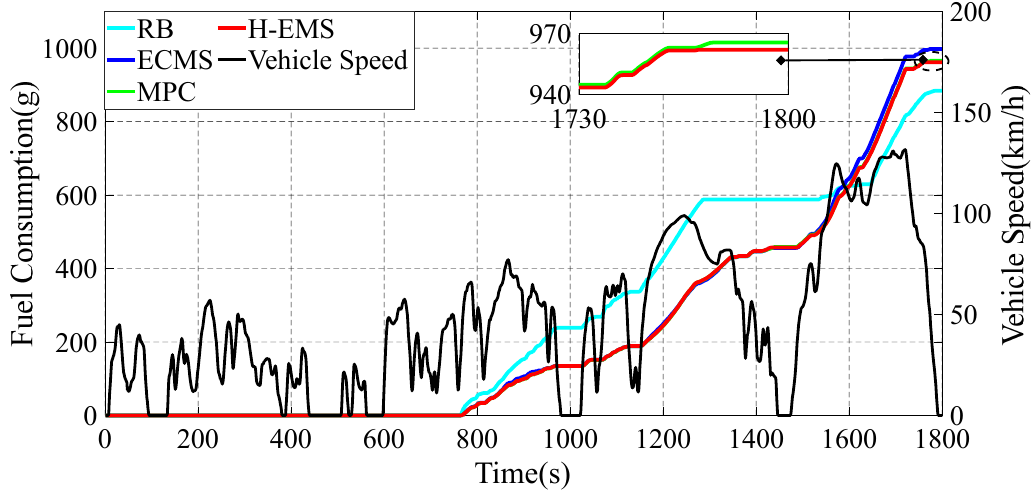
Figure 9. Variation curves of vehicle speed and fuel consumption under different strategies.